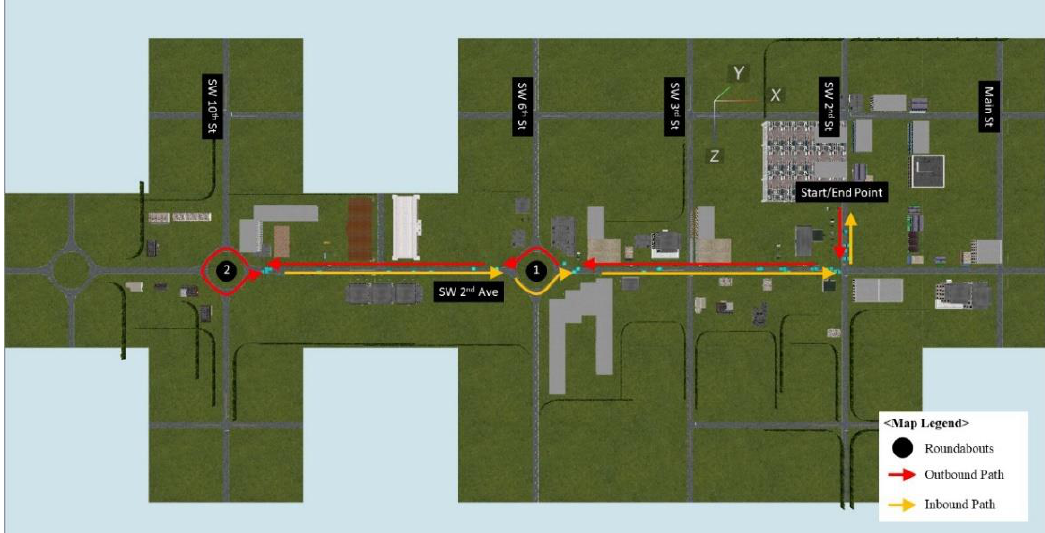
Figure 2. Driving Simulator Route: Ten-minute automated driving simulation (Level 4, SAE) consisted of roundabouts, turns, and stops following the outbound (red) and inbound (yellow) pathways.